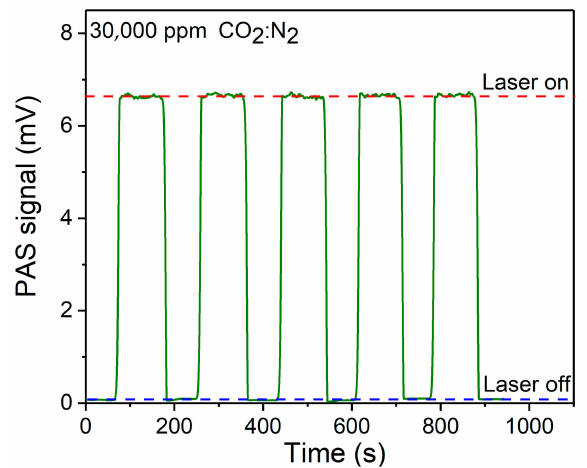
Figure 4. Signal stability of the reported FW-QCL based CO 2 sensor system.